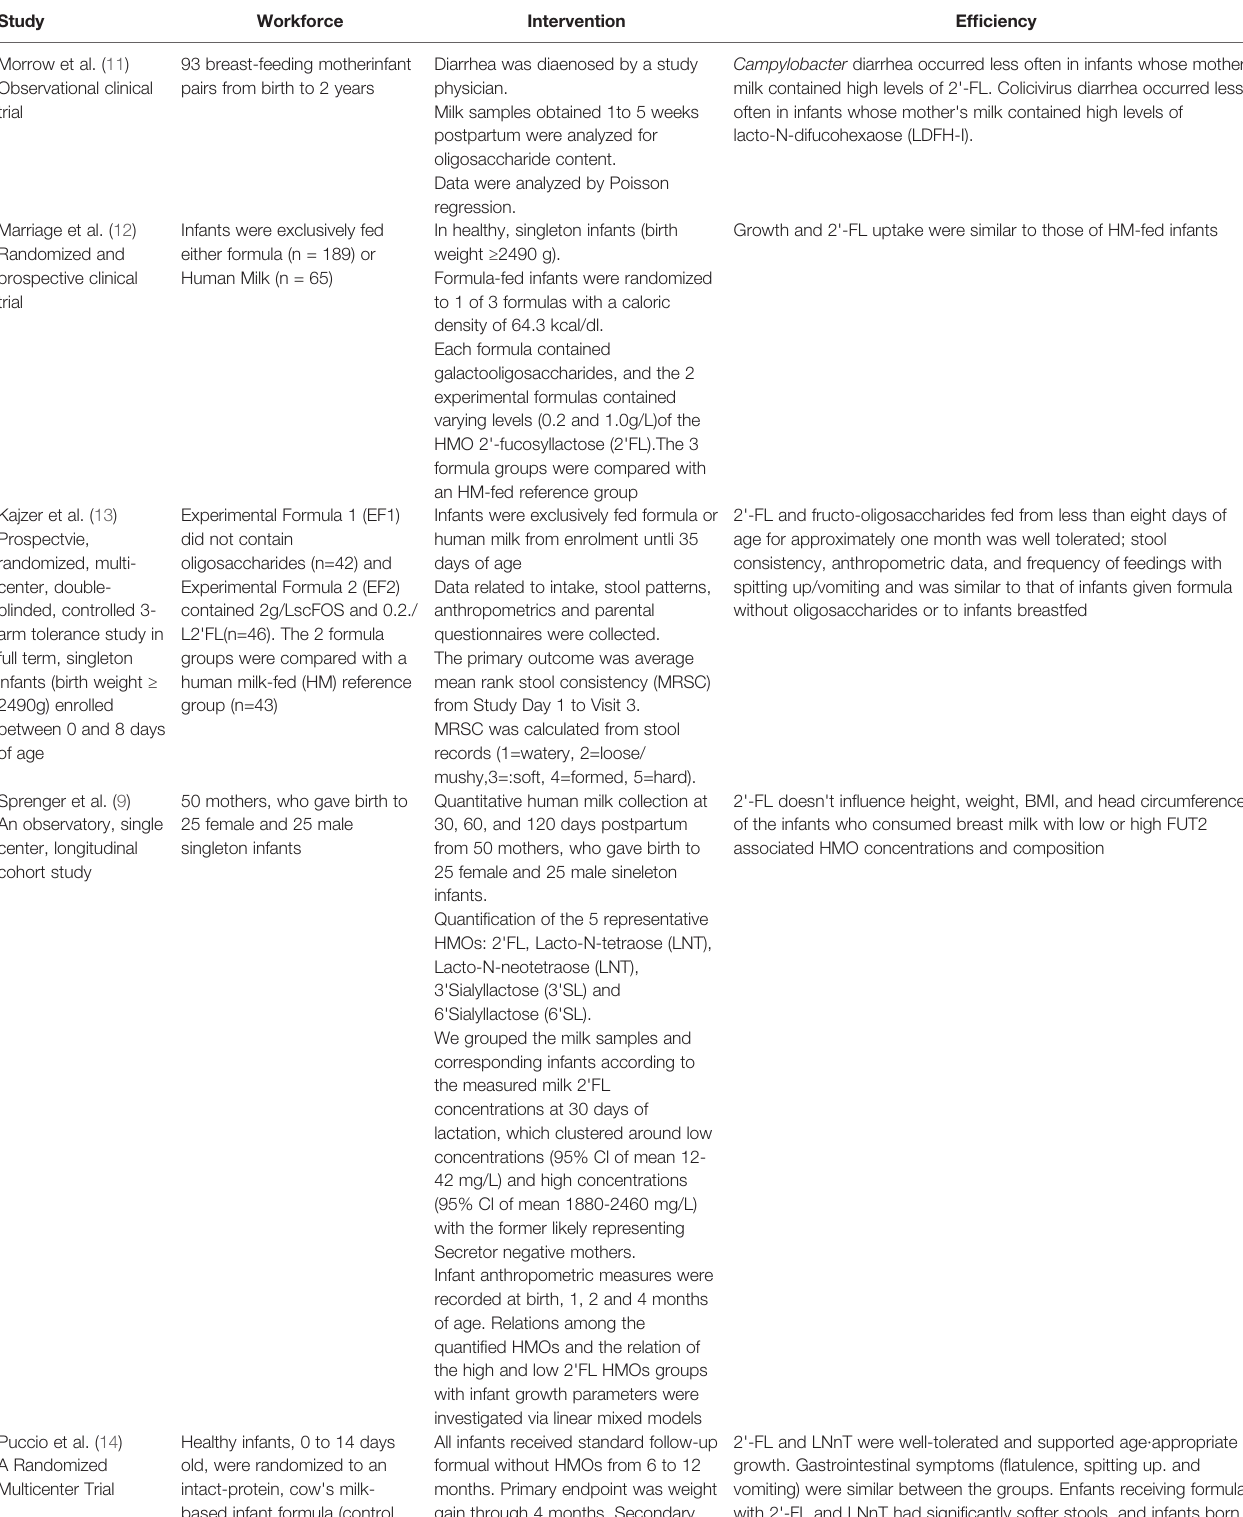
TABLE 1 | Overview of studies used in this review demonstrating the role of HMOs in host protection (clinical trials). Study Workforce Intervention Ef fi ciency Morrow et al. (11) 93 breast-feeding motherinfant Diarrhea was diaenosed by a study Observational clinical pairs from birth to 2 years physician. trial